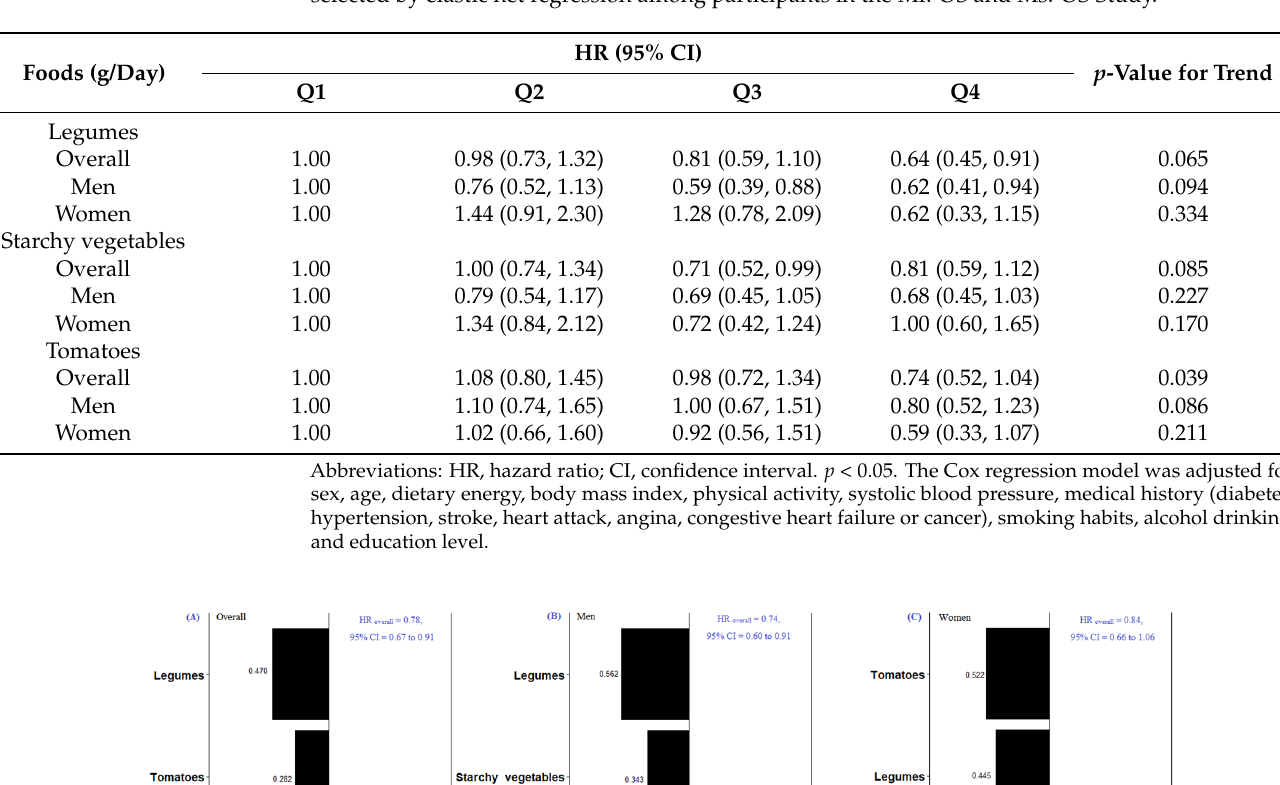
Table 3. Prospective association of the quartile (Q) of food groups with cardiovascular mortality selected by elastic net regression among participants in the Mr. OS and Ms. OS Study.